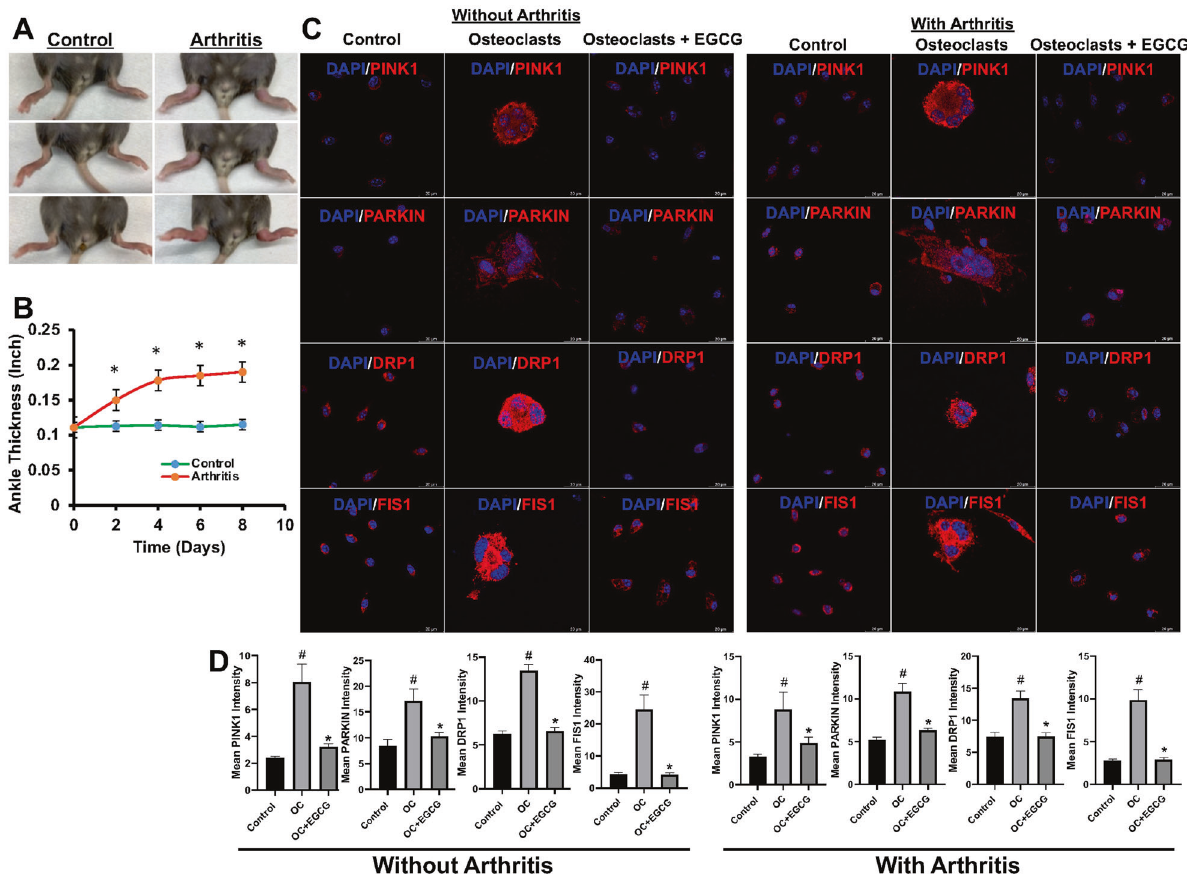
Fig. 5 Effect of EGCG in the expression of mitophagy-related molecules in primary BM isolated from without or with K/BxN serum- induced arthritis mice. A Representative images of the K/BxN serum-induced arthritic in fl ammation of limbs (in C57BL/6 female mice). B Measured ankle thickness during the course of arthritis development is shown graphically. C Representative IF staining images of PINK1, PARKIN, DRP1, and FIS1 were shown during the OC differentiation of with or without arthritis mice in the presence or absence of EGCG. D Quanti fi ed mean intensity graph for IF staining shown. Results are shown in mean ± SEM ( n = 3). (#), p < 0.05 compared with basal condition; and (*), p < 0.05 compared with induced OC differentiated